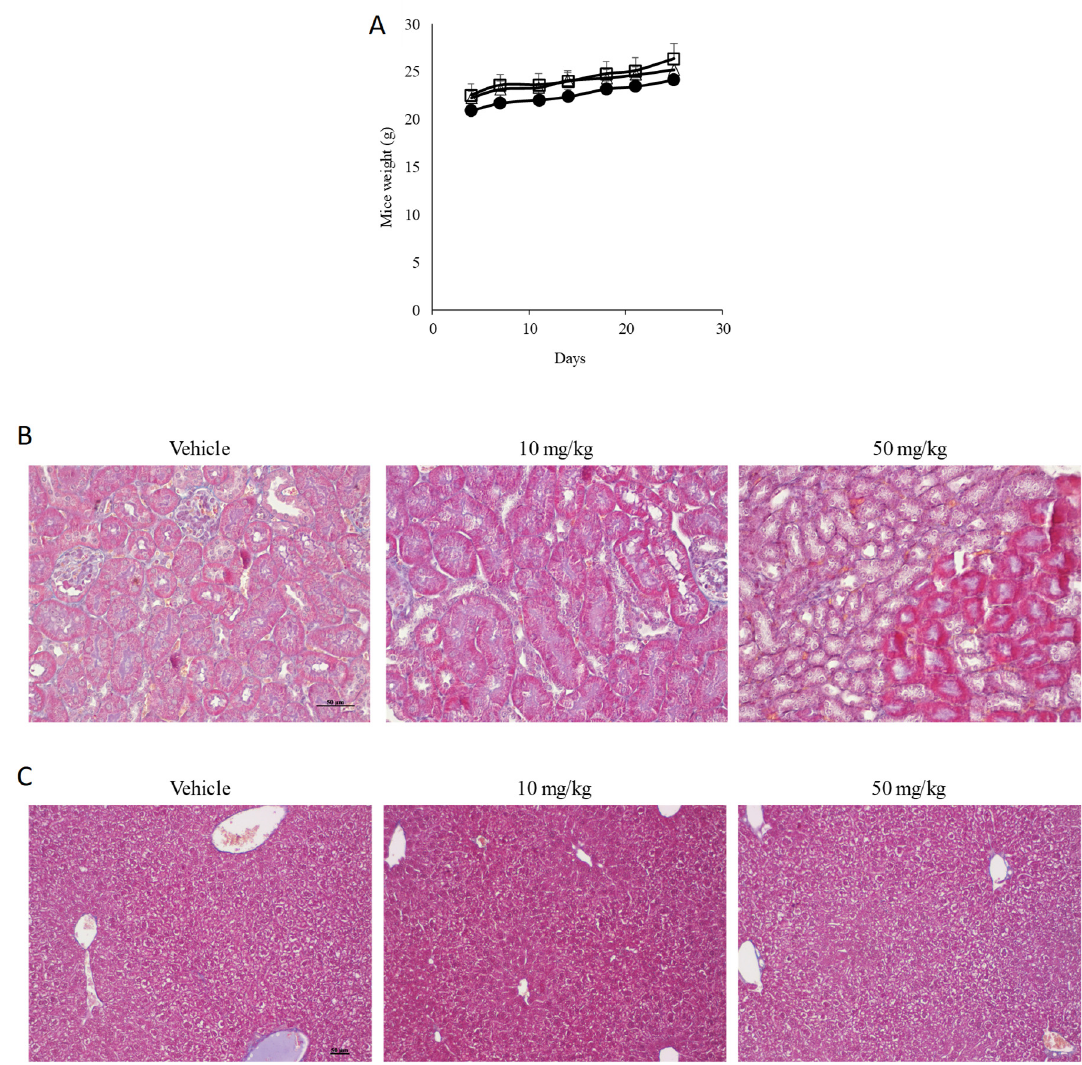
Figure 8. Pyridazinone scaffold-based molecules do not show toxicity in vivo in an orthotopic osteosarcoma model. Mice weight evolution in a time-dependent manner after intraperitoneal injection of vehicle (square), compound 4ba at 10 mg/kg (triangle) and at 50 mg/kg (circle) ( A ). Representative field of histological analysis of liver ( B ) and kidney ( C ). Scale bar = 50 µm, n = 7.